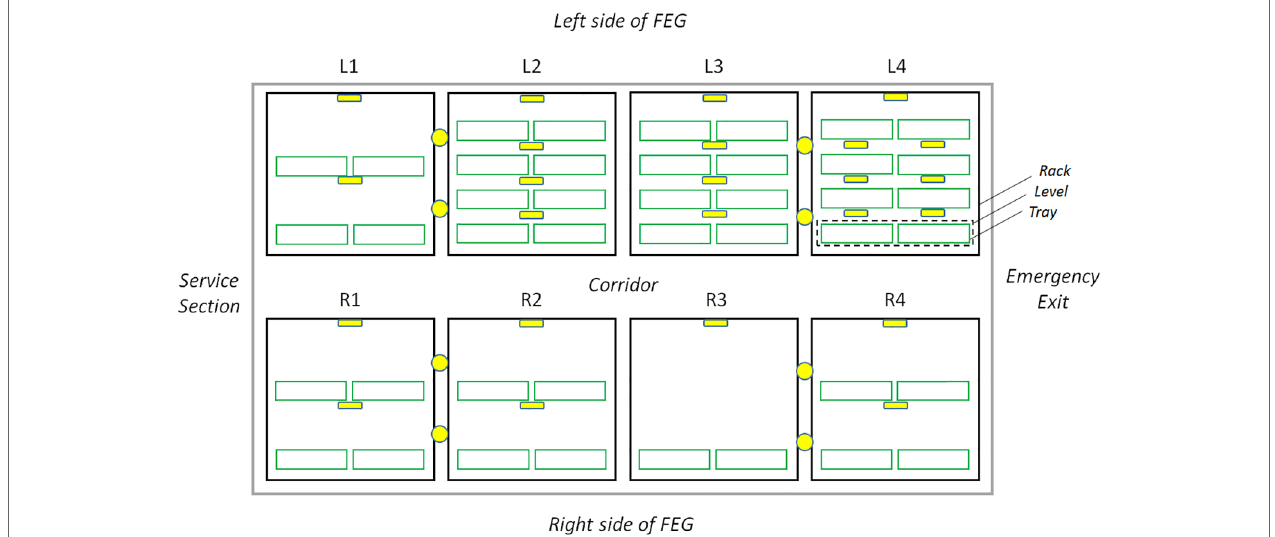
FIGUrE 4 | Layout of the HD Color Imaging System inside the FEG. The yellow circles represent the lateral view cameras and the yellow squares the top view cameras. Four plant growth racks (black outline) are present on each side of the container, called L1 to L4 for the left side and R1 to R4 on the right side. Each rack is subdivided into up to four growth levels (green outline) consisting of two trays for plant